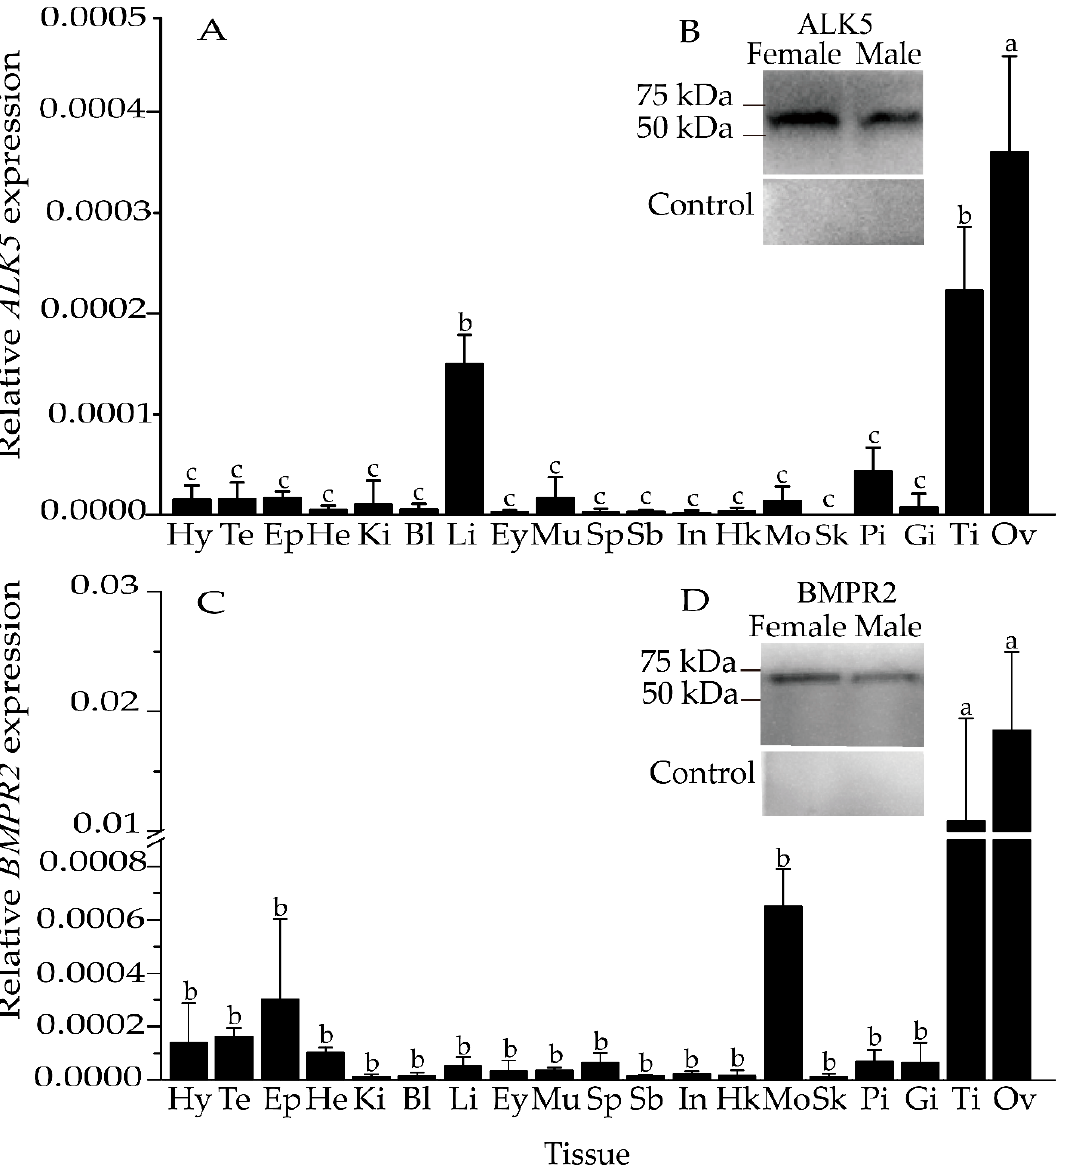
Figure 2. Tissue distribution of ALK5 ( A ) and BMPR2 ( B ) in S. prenanti determined by qRT–PCR, and ALK5 and BMPR2 immunoreactivity in the ovary and testis ( C , D ). Hy, hypothalamus; Te, telencephalon; Ep, epithalamus; He, heart; Ki, kidney; Bl, blood; Li, liver; Ey, eye; Mu, muscle; Sp, spleen; Sb, swim bladder; In, intestine; Hk, head kidney; Mo, medulla oblongata; Sk, skin; Pi, pituitary; Gi, gill; Ti, testis; Ov, ovary. The data are represented as the means ± SEMs (n = 5). Means marked with different letters are significantly different ( p < 0.05).